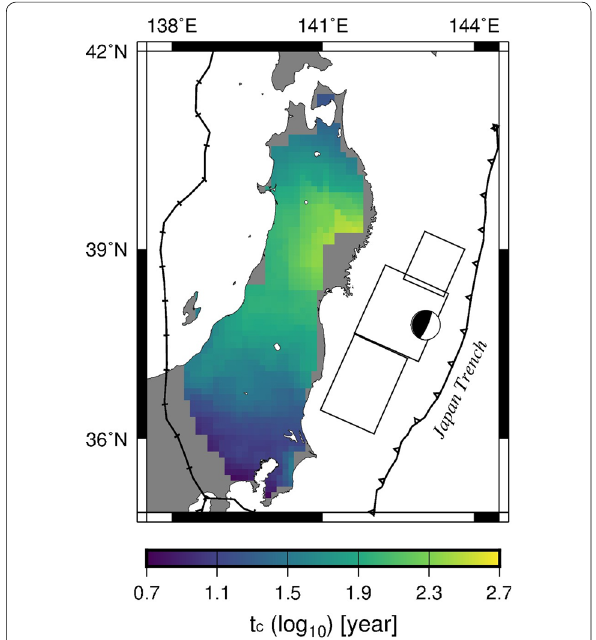
Fig. 5 Distribution of the reference of convergence time of postseismic deformation in the horizontal components, t c , as time of d ( t ) = 1 cm/year (a typical value of tectonic deformation)